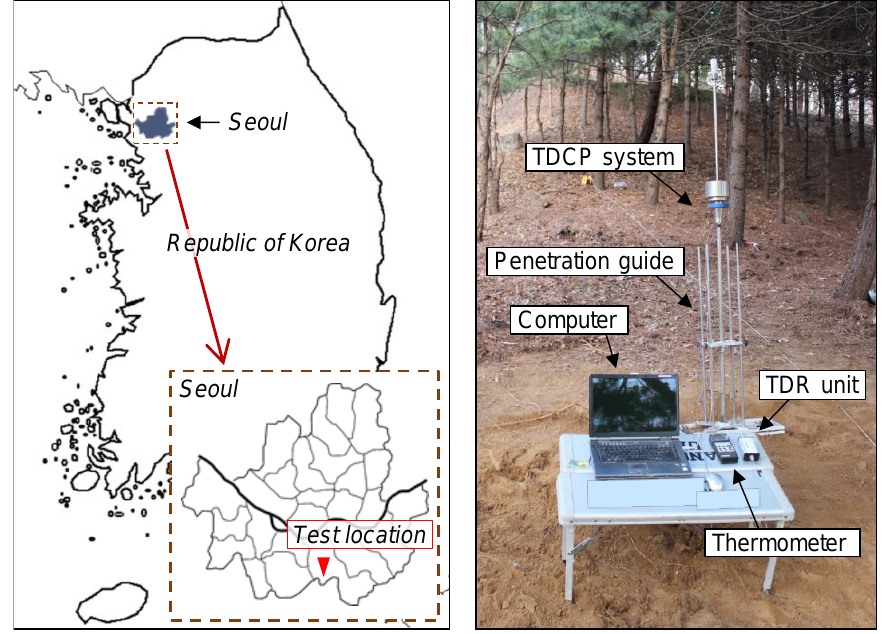
Figure 11. Experimental setup for the field application test.